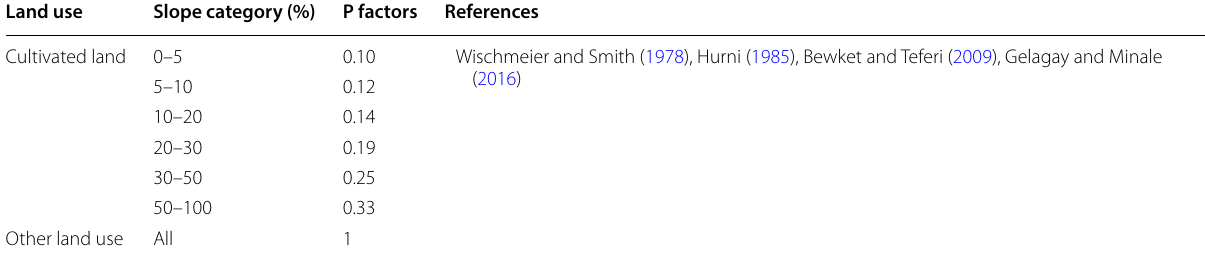
Table 5 Land management factor (P) values suggested by Wischmeier and Smith (1978) Source: Author’s analysis,